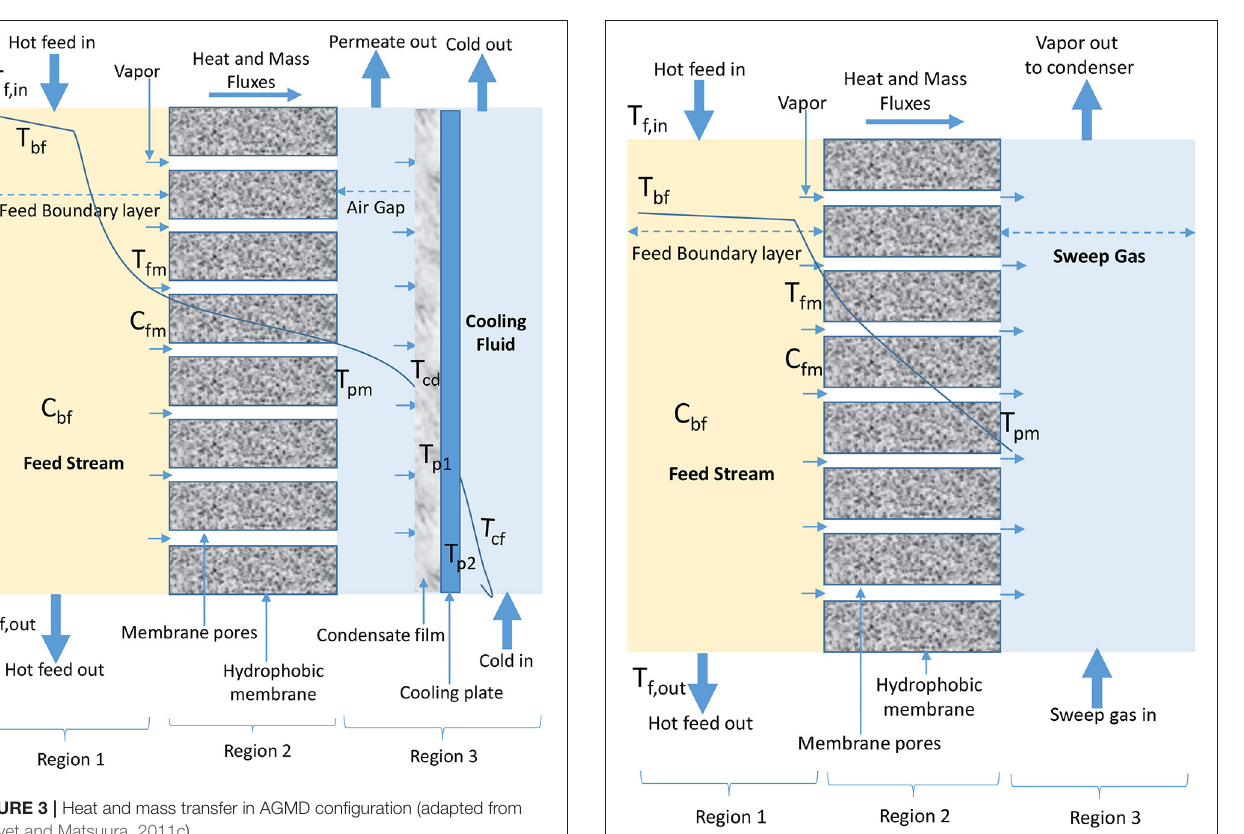
FIGURE 4 | Heat and mass transfer in SGMD configuration (adapted from Khayet and Matsuura,